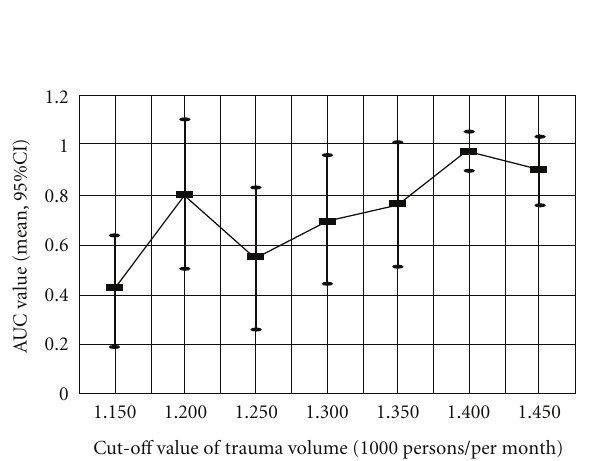
Figure 2: Graph illustrates AUC values for di ff erent cut-o ff values of trauma